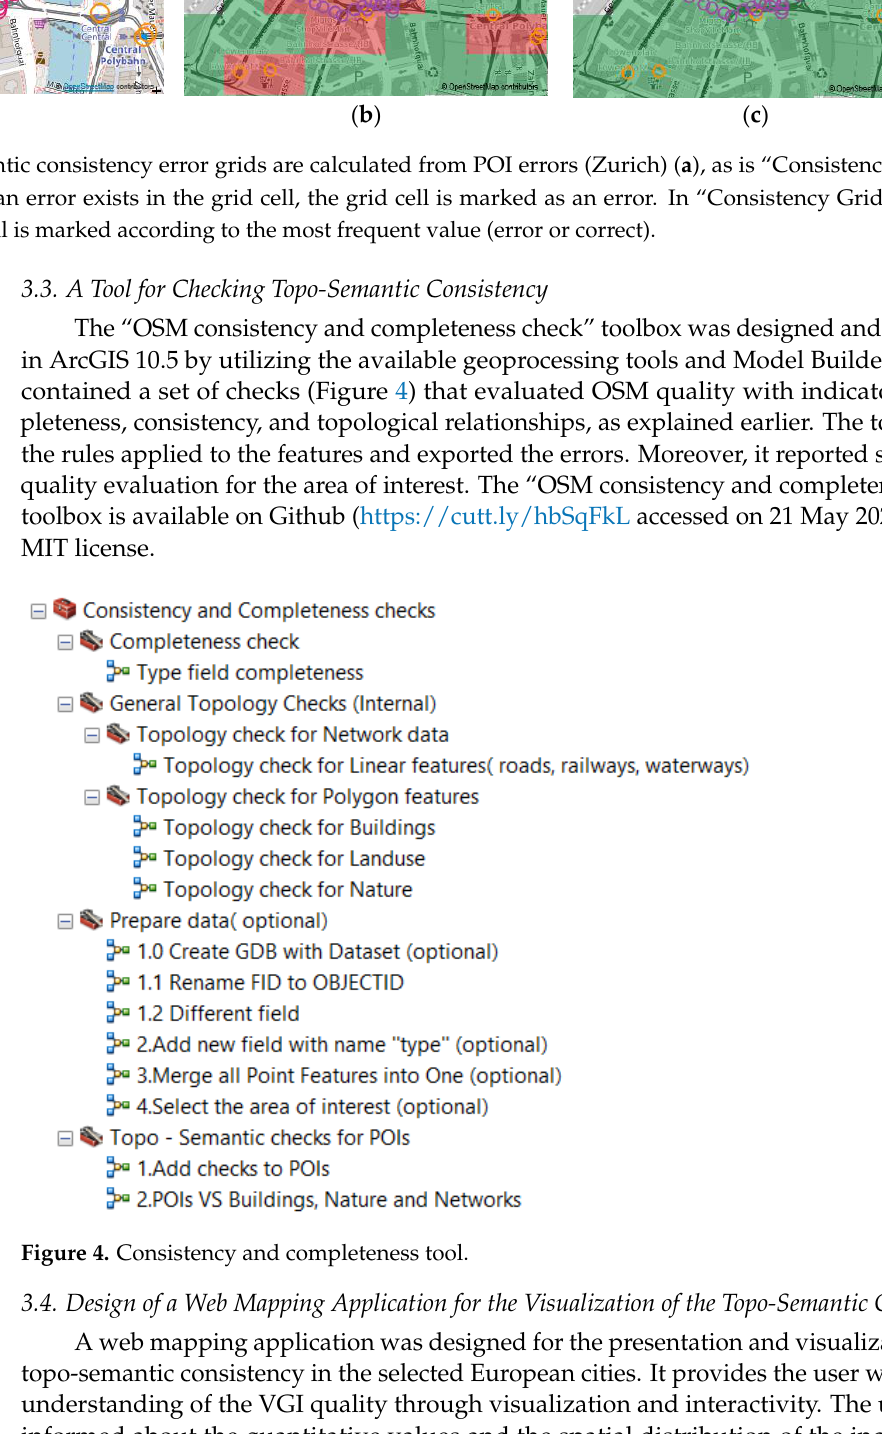
“Consistency Grid (error existence)” (Figure 3b), the grid cell was marked as an error if